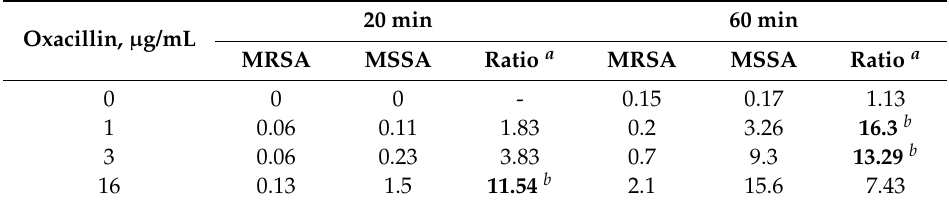
Table 3. Normalized cell death response of MSSA and MRSA at different time points of exposure to oxacillin.